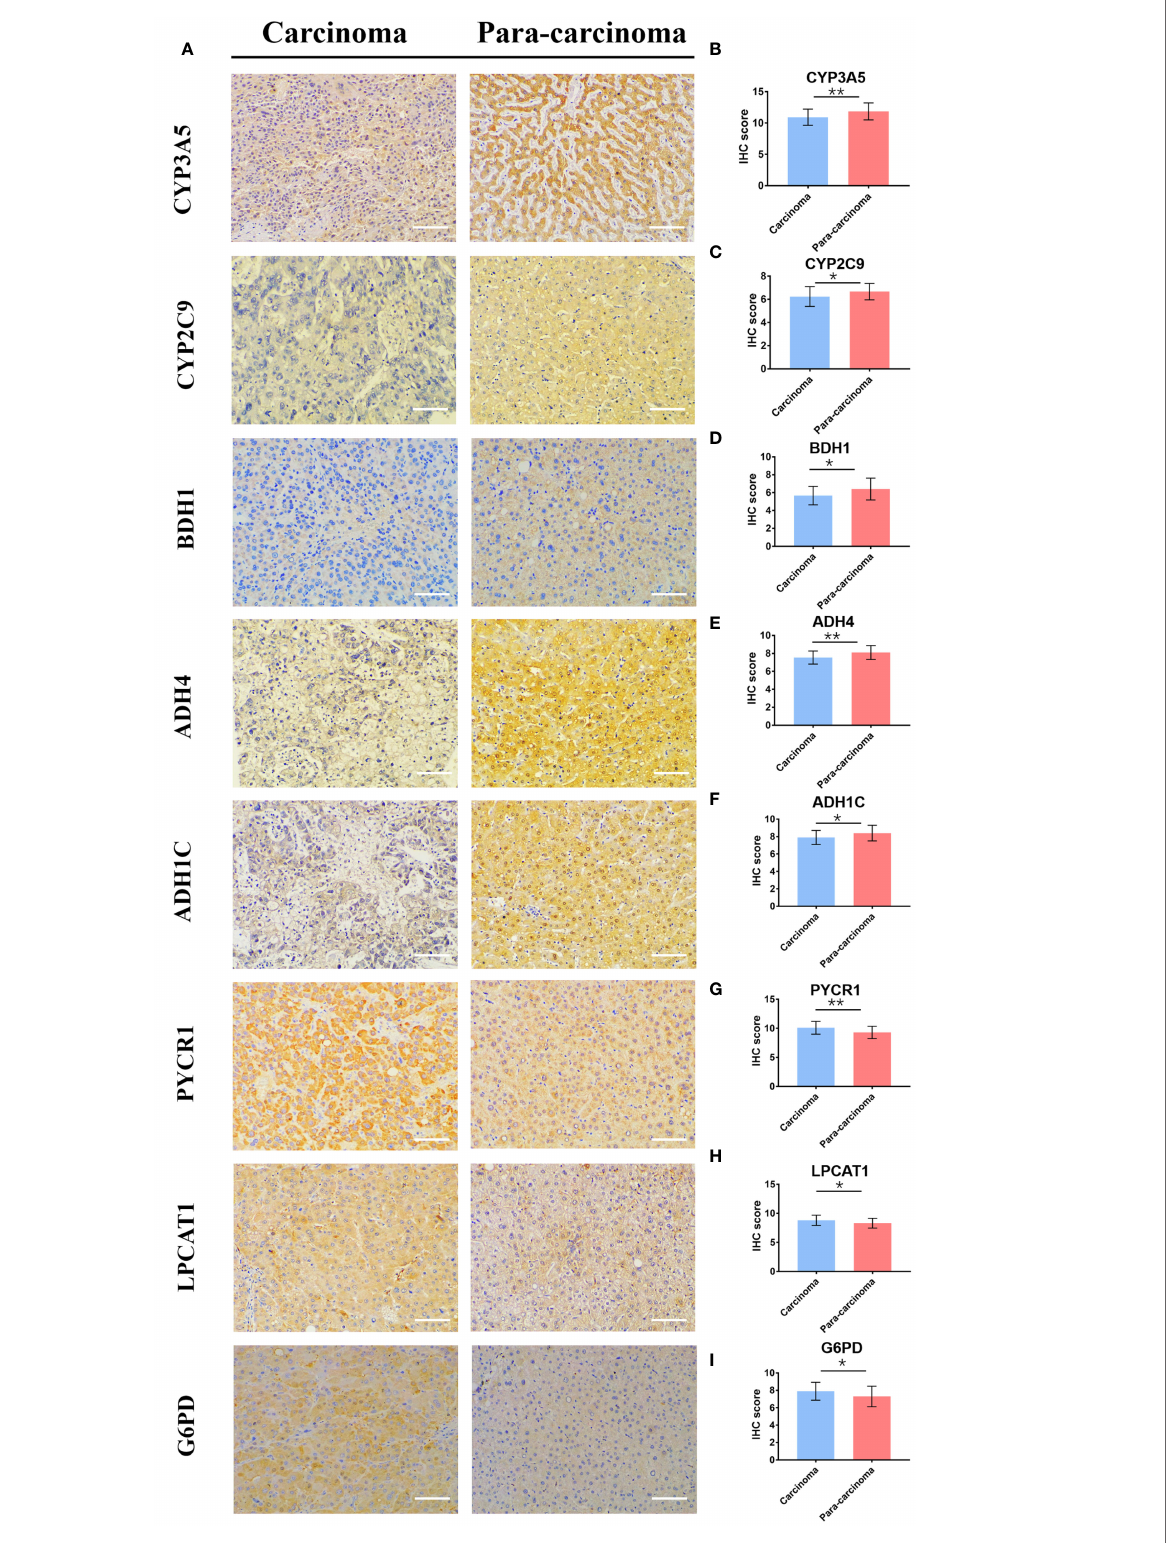
FIGURE 8 | The differential expression of 8 genes in cancer and matched normal tissues. (A) Representative image of immunohistochemistry staining and (B – I) immunohistochemical staining scores. (× 200, scale bar = 100 µm). Data are presented as the means ± SD. * p < 0.05 and ** p <